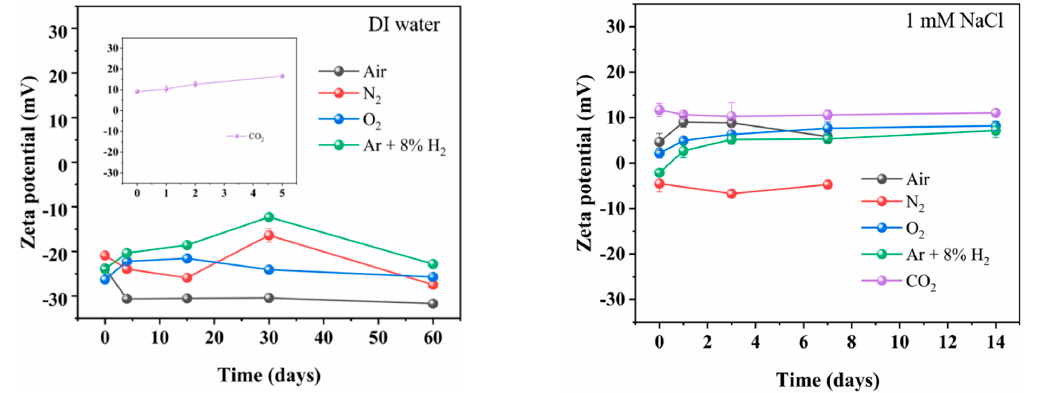
Figure 3. Effect of time on nanobubble mean diameter of different kind of gases (N 2 , O 2 , Ar + 8%H 2 air and CO 2 ) in ( A ) deionized water, ( B ) 1 mM NaCl aqueous solution, ( C )1 mM CaCl 2 aqueous solution and ( D ) 1 mM AlCl 3 aqueous solution.